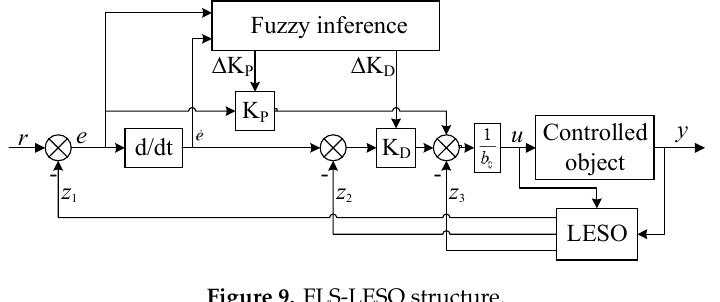
Figure 9. FLS-LESO structure.